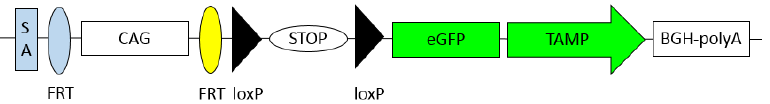
Figure 1. Schematic overview of the introduced sequences coded on a vector pROSA/MD3. SA: splice acceptor site; FRT: FRT-site for recognition by Flippase (Flp); CAG: CAG-promotor [26]; loxP: target sequence for Cre-recombinase; STOP: Stop-codon sequence; eGFP: enhanced green fluorescent protein; TAMP: cDNA sequence of murine MARVELD3 variant 2 (corresponding to the human variant 1); BGH-polyA: polyadenylation and, thereby, transcription termination site.